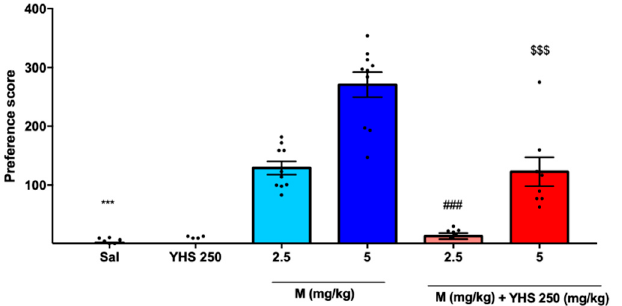
Figure 4. Morphine-induced CPP is inhibited by YHS after i.p. administration . Preference scores calculated based on ani- mal’s time spent in the drug-paired chamber vs. the non-drug-paired chamber during the pre- and post-preference periods (n = 8–11). The black dots correlate to the number of animals used in each experiment. One-way ANOVA revealed signif- icant drug addiction in all morphine groups and a reduction in the combination groups F = 62.50 p < 0.0001, followed by Tukey’s multiple comparison test, *** p < 0.0001 compared with M2.5, M5, and M5 YHS250, ### p < 0.0001 compared with M2.5, M5, and M5 YHS250, $$$ p < 0.0001 compared with M5 and M2.5 YHS 250. YHS reverses morphine tolerance and dependence.